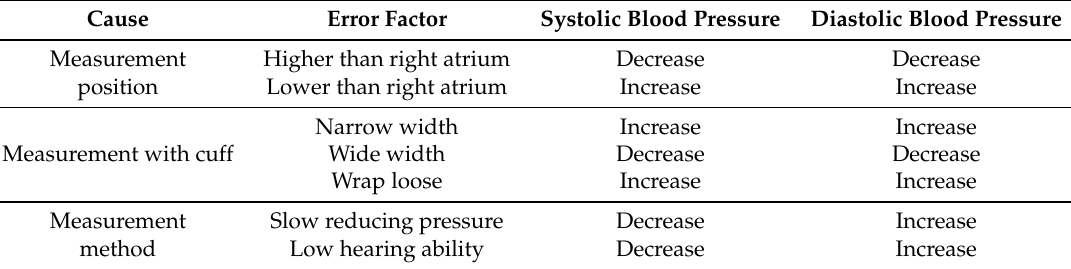
Table 2. Main error factor of the methods of blood pressure measurement